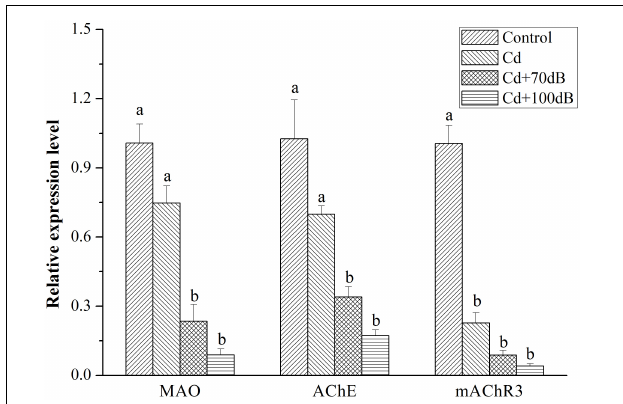
FIGURE 6 | Relative expression levels of the genes encoding neurotransmitter modulatory enzymes and receptors after 10 days of exposure to the control (without Cd and anthropogenic noise), 50 µ g/L Cd, 50 µ g/L Cd + 70 dB re 1 µ Pa anthropogenic noise, and 50 µ g/L Cd + 100 dB re 1 µ Pa anthropogenic noise. Means not sharing the same superscript are significantly